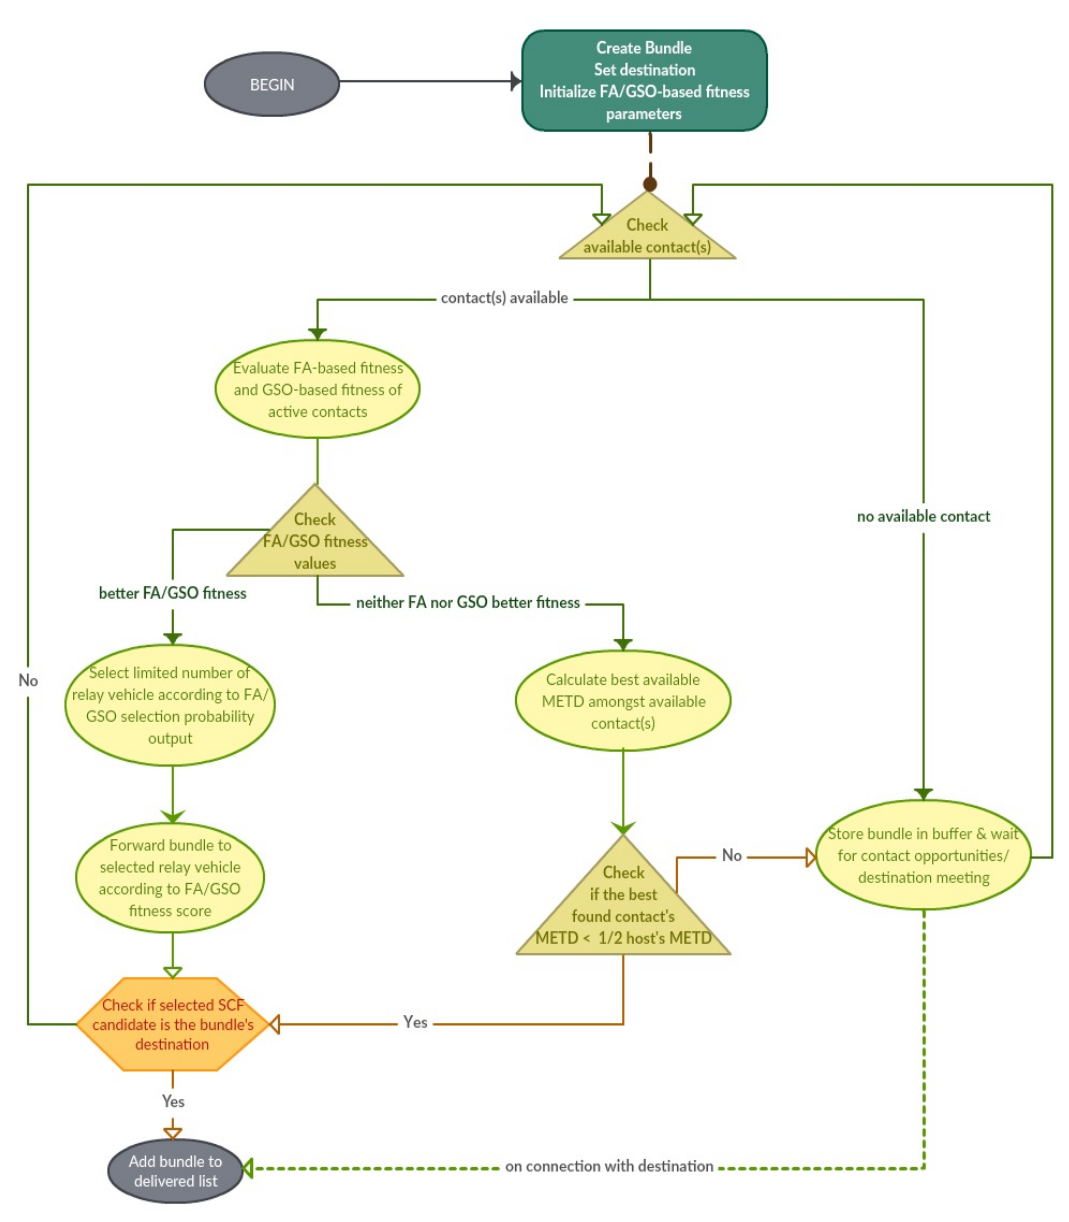
Figure 3. Hybrid Firefly–Glowworm VDTN solution flowchart.